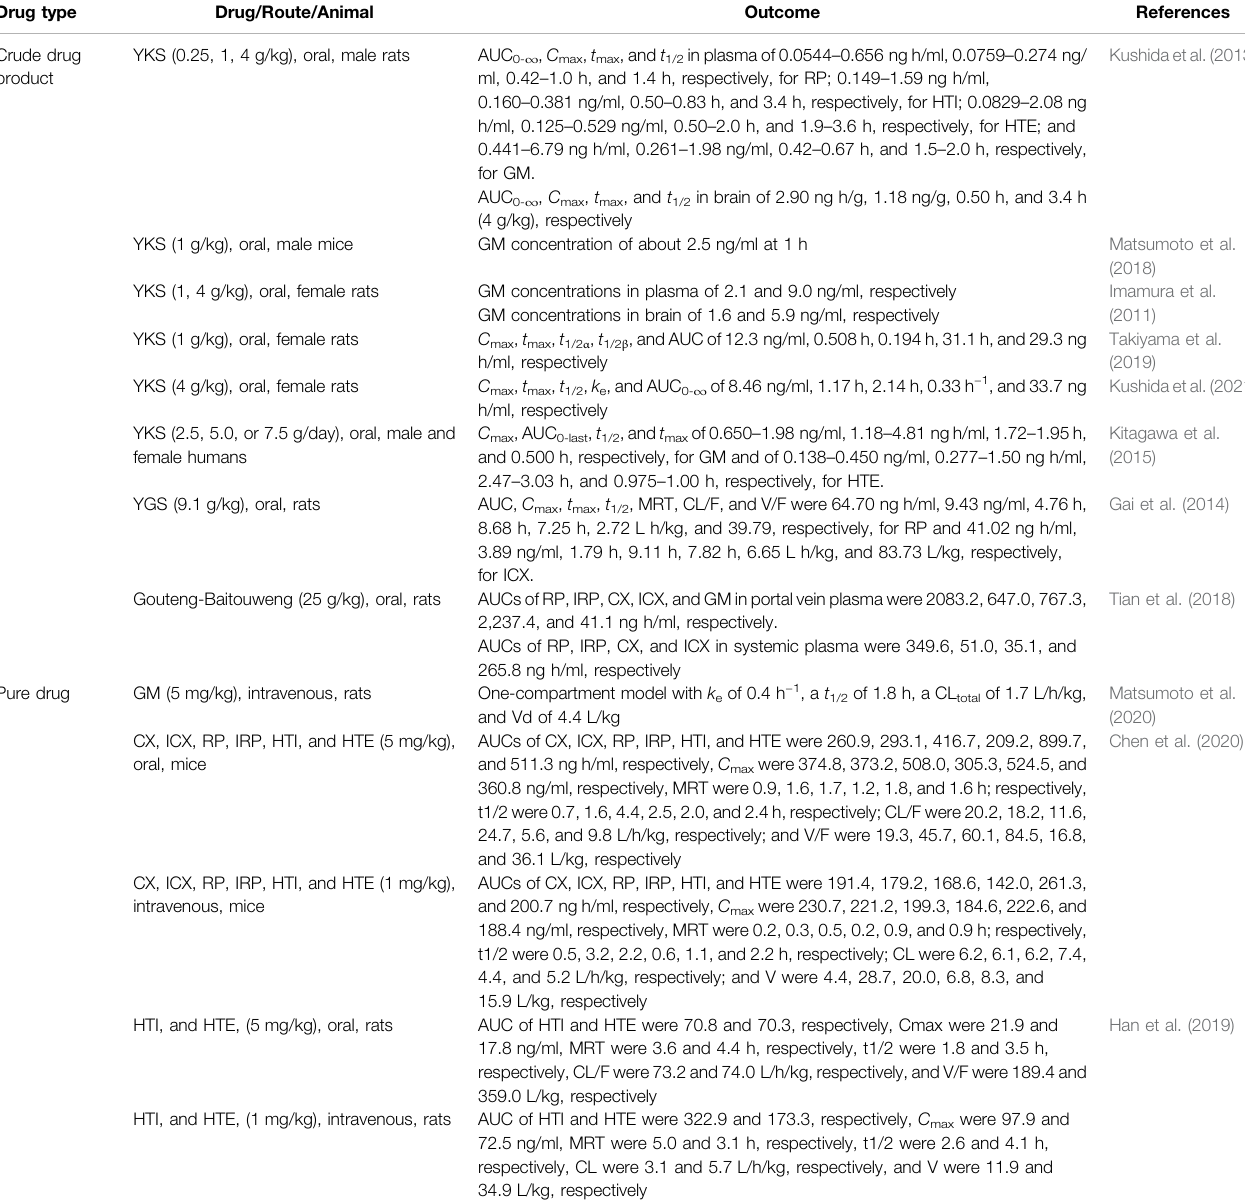
TABLE 2 | Pharmacokinetic studies of UH